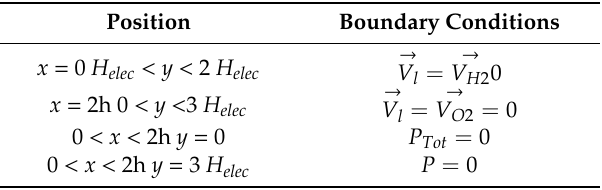
Table 1. The boundary conditions to solve the